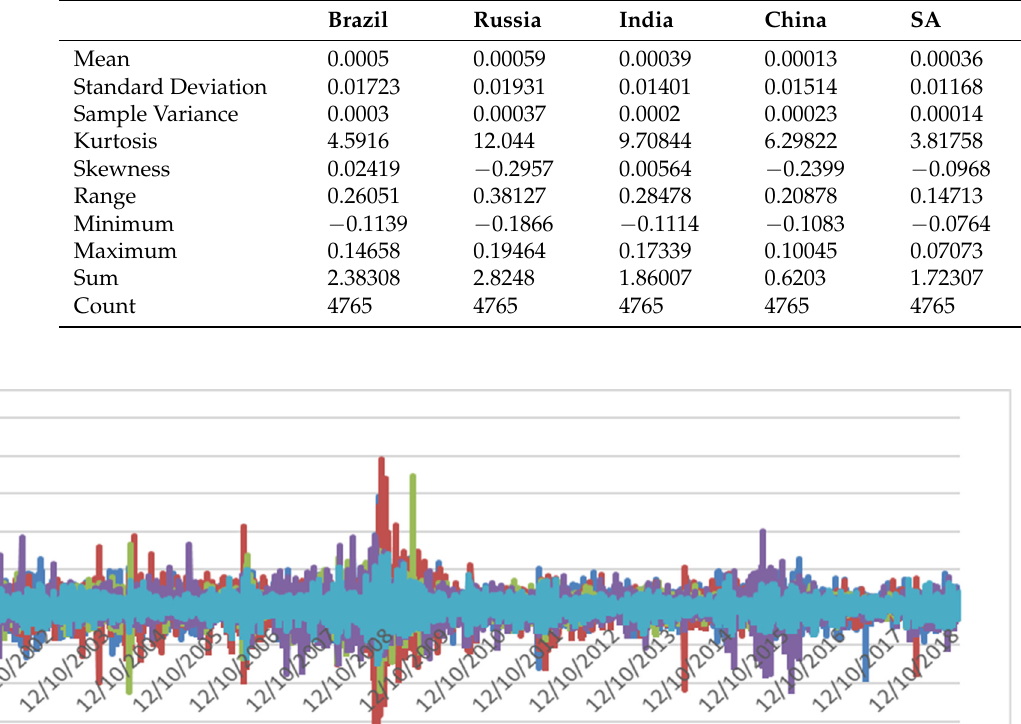
Table 1. Descriptive statics.